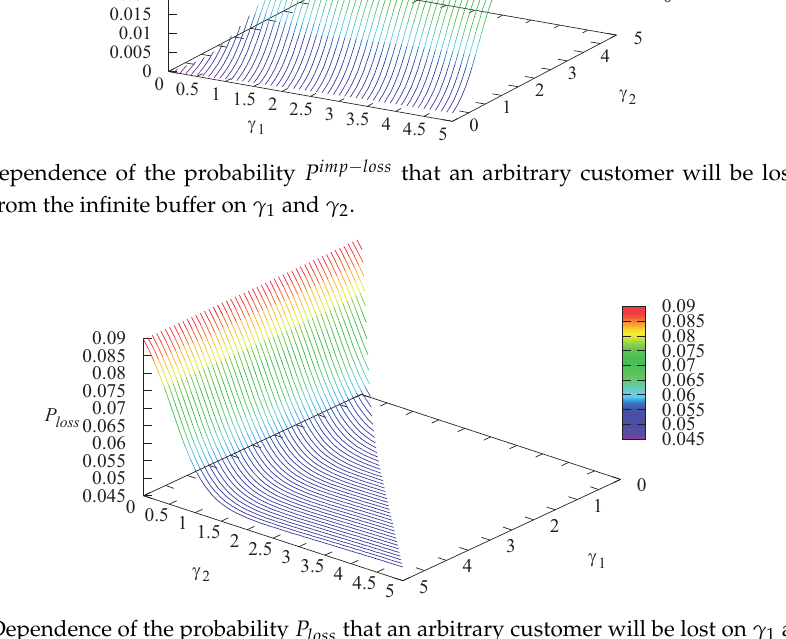
Figure 9. Dependence of the probability P loss that an arbitrary customer will be lost on γ 1 and γ 2